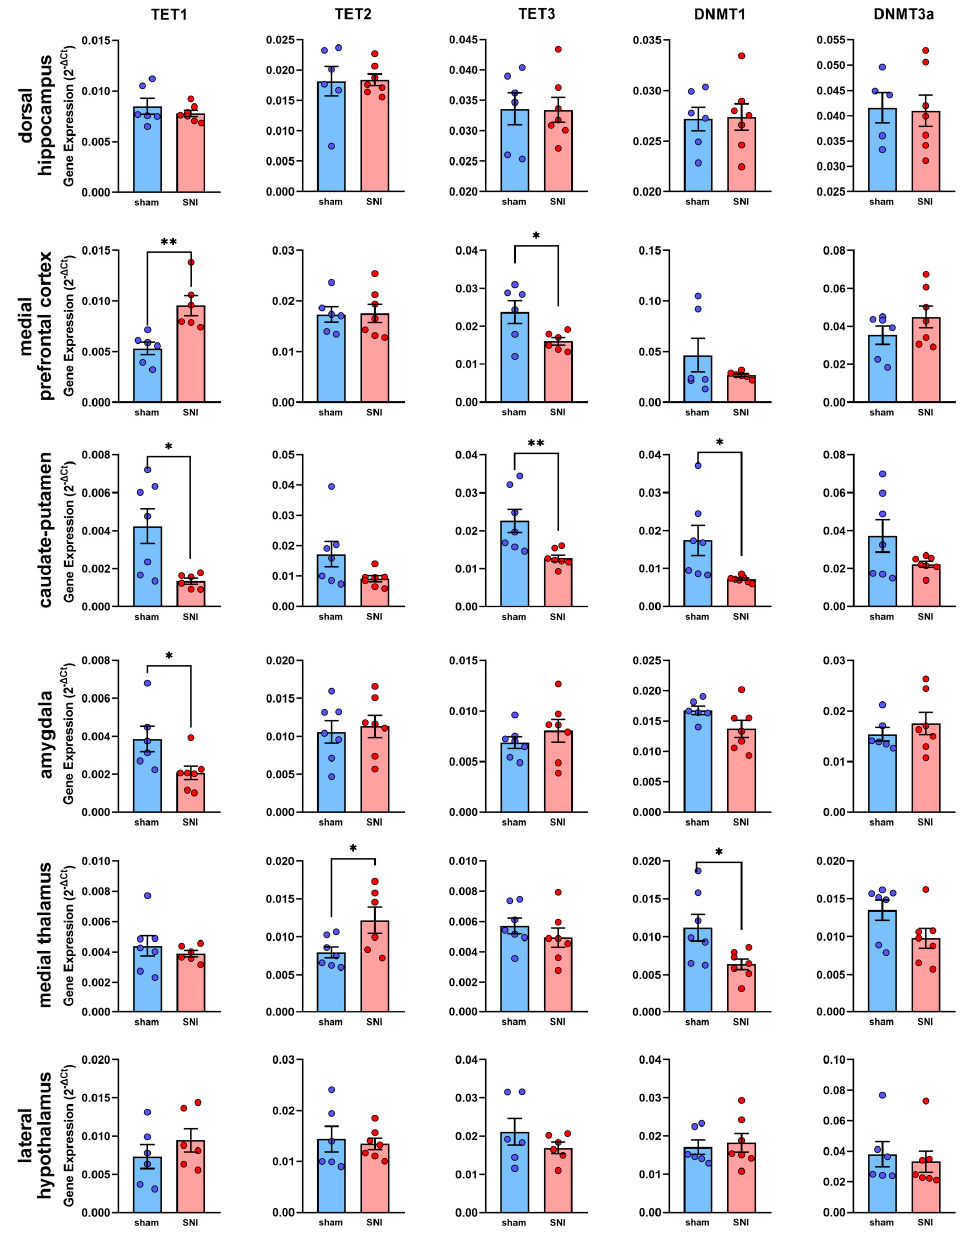
Figure 2. Gene expression in the dorsal hippocampus, medial prefrontal cortex, caudate-putamen, amygdala, medial thalamus, and lateral hypothalamus, contralateral to the SNI neuropathic pain model lesion ( n = 7 per group). Gene expression was assessed by real-time PCR using GAPDH as housekeeping gene. Each bar represents the average of individual tissue samples run separately from both control (sham) and pain animals (SNI). Statistical analyses were performed using the t-Student parametric test or the Mann–Whitney non-parametric test, depending on the normality of the group sample. TET1-3, ten-eleven translocation methylcytosine dioxygenase 1-3; DNMT1/3a, de novo DNA methyltransferases 1/3a. *, p < 0.05; **, p < 0.01.